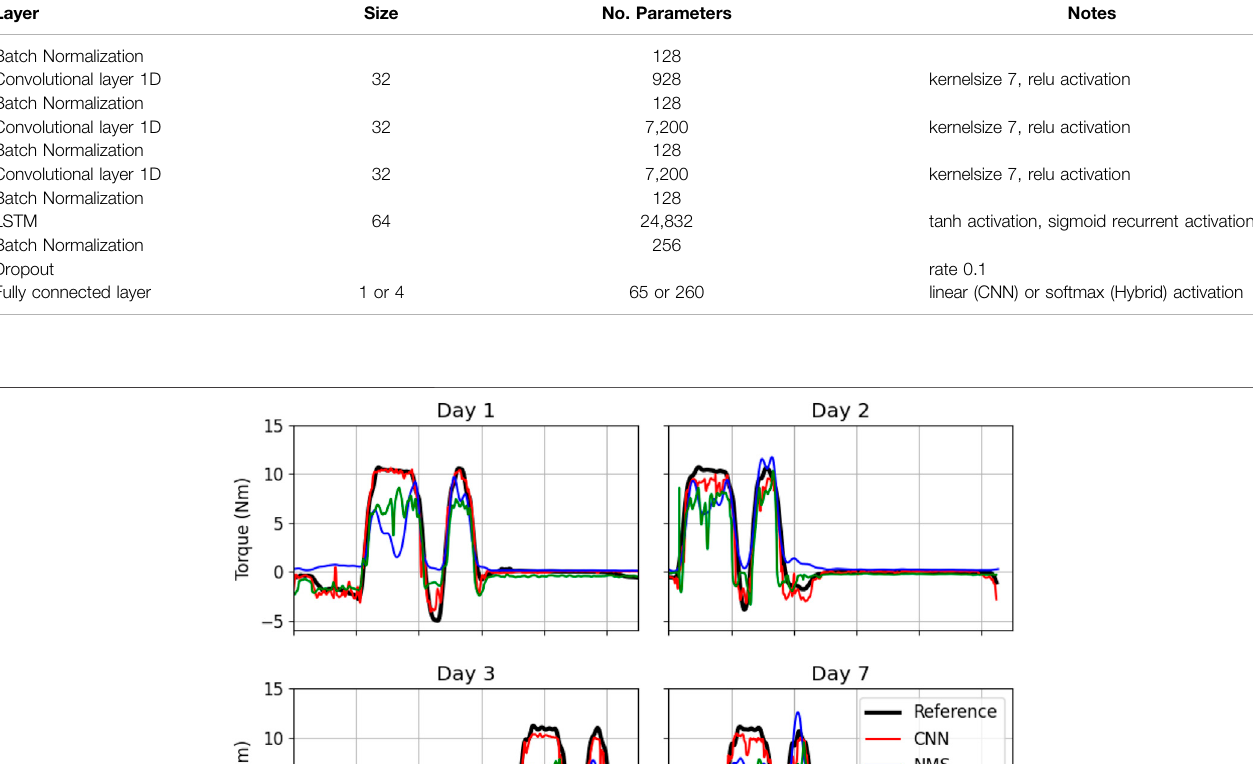
TABLE 1 | Optimized architecture of the CNN model and the CNN part of the hybrid model. Layer